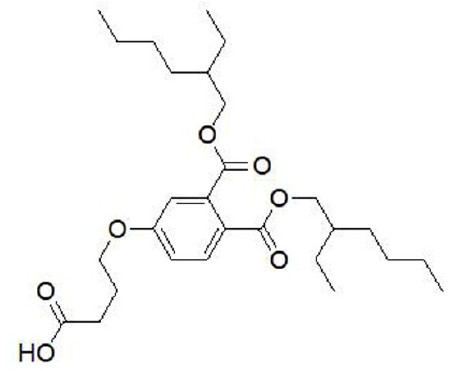
Figure 8. Structure of carboxy-modified DEHP.